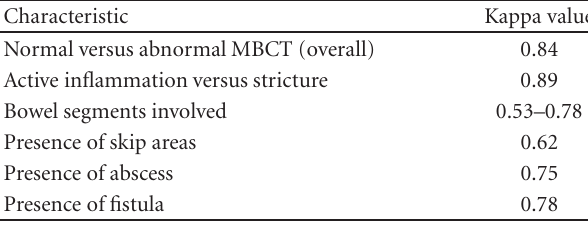
Table 1: Kappa scores for MBCT results in patients with followup of pathologically proven Crohn’s disease.